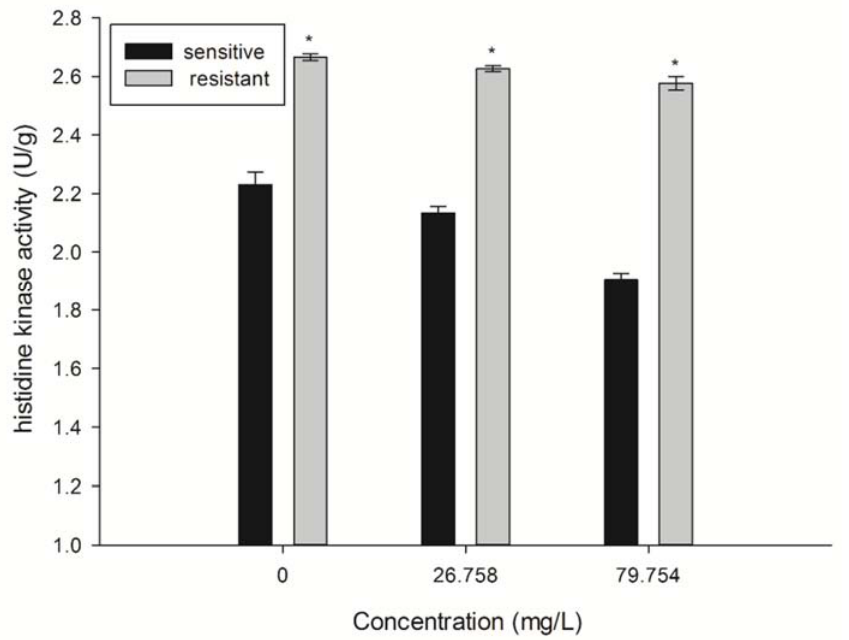
Figure 6. The histidine kinase (HK) activity of B. cinerea with SYAUP-CN-26. Values are presented as mean ± S.E. (n = 3) and are significant for * p < 0.05.